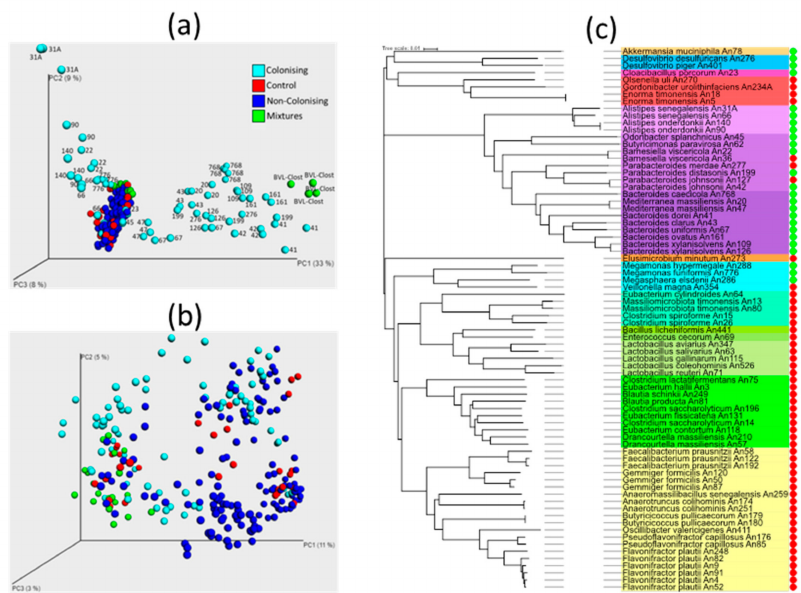
Figure 1. Gut microbiota composition in the caecum of newly hatched chicks. ( a ) Weighted principal coordinate analysis (PCoA) indicating gut anaerobes capable of colonisation. Chicks inoculated with isolates not capable of colonisation (dark blue dots) clustered together with control chicks (red dots). Dots outside this cluster represent chicks that were inoculated with isolates capable of caecum colonisation (light blue dots), and these are identified by the numbers of their An codes (see Table S1). Green dots—chicks inoculated with di ff erent defined mixtures. Not all isolates capable of colonisation can be seen in panel ( a ) because the projection of some successfully colonised chicks along PC3 resulted in an overlap with the cluster of control chicks. ( b ) According to unweighted PCoA, successful colonisation did not a ff ect composition of the rest of the microbiota. The same colour coding is used in panels ( a – c ). Cluster alignment based on the whole gene sequence of 16S rRNA genes and ability to colonise the chicken caecum during the first week of life. Isolates with a green dot to the right of the dendrogram were detected in caeca of 8-day-old chicks. On the other hand, those with red dots were not detected. Families with a yellow, green, or light-blue background belong to phylum Firmicutes. Families with di ff erent shades of magenta belong to phylum